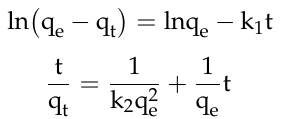
Figure 9 represents the plot of [t vs. ln(q e − q t )] and [tv vs. t/q t ] for the pseudo-first order and the pseudo-second order, respectively. Table 1 represents the kinetic parameters for both models. The regression coefficients for the pseudo-first and pseudo-second order are R 2 = 0.92 and R 2 = 0.99, respectively, which showed that the adsorption of oil into the beads is best described by the pseudo-second order. The adsorption capacity was also determined graphically with a maximum value of 625 mg/g, and with a rate constant